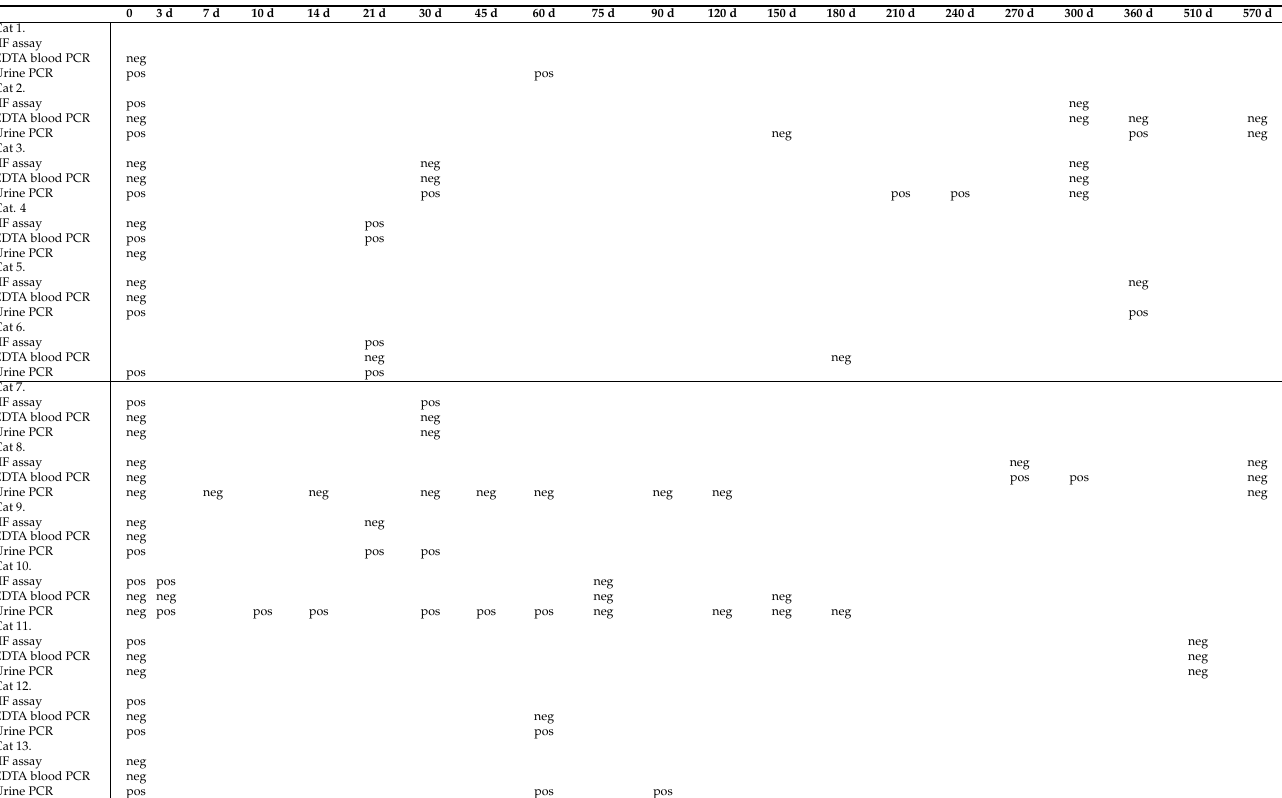
Table 11. Indirect immunofluorescence (IIF) and PCR (blood and/or urine) test results in FeMV positive followed up cats. Results refer to the sampling day. d = day; pos = positive; neg =